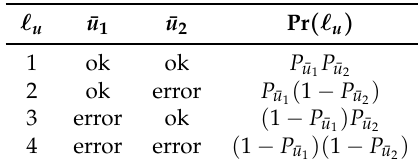
Table 2. Probability of each mode in (cid:96) u